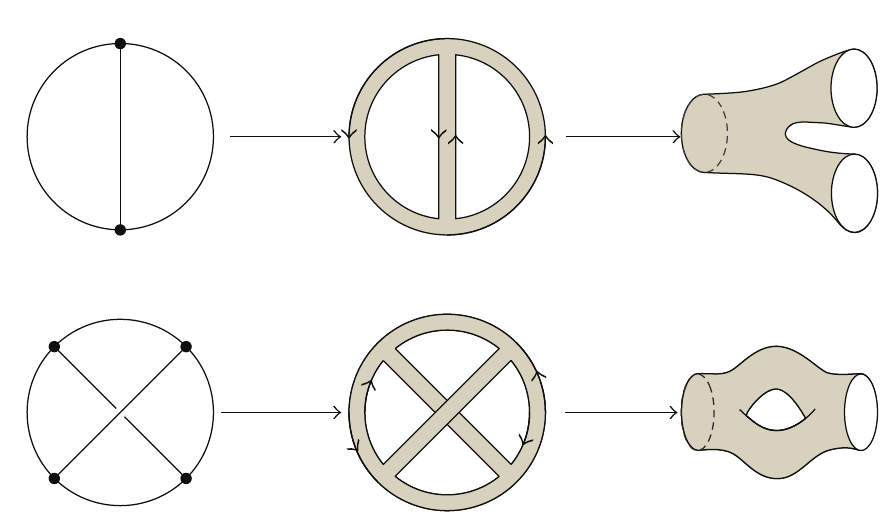
Figure 1: Feynman diagrams (cid:2) left (cid:3) can be translated to double-line diagrams (cid:2) middle (cid:3) , which in turn can be interpreted as Riemann surfaces of well-defined topology (cid:2) shaded (cid:3) . These surfaces (cid:2) deformed to the shape on the right (cid:3) can be interpreted as stringy Feynman